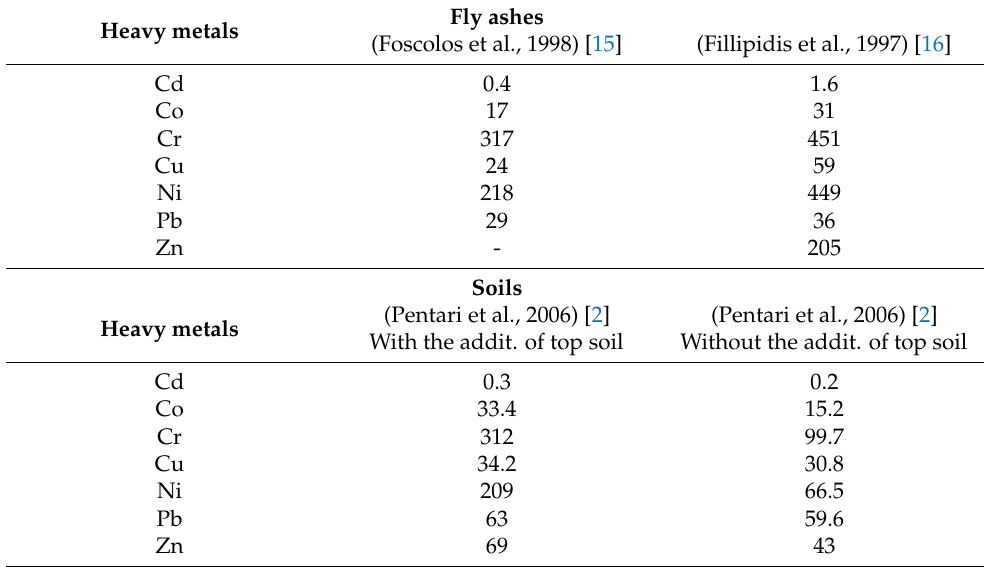
Table 1. Concentrations, in ppm, of heavy metals of environmental interest in fly ashes and re- claimed